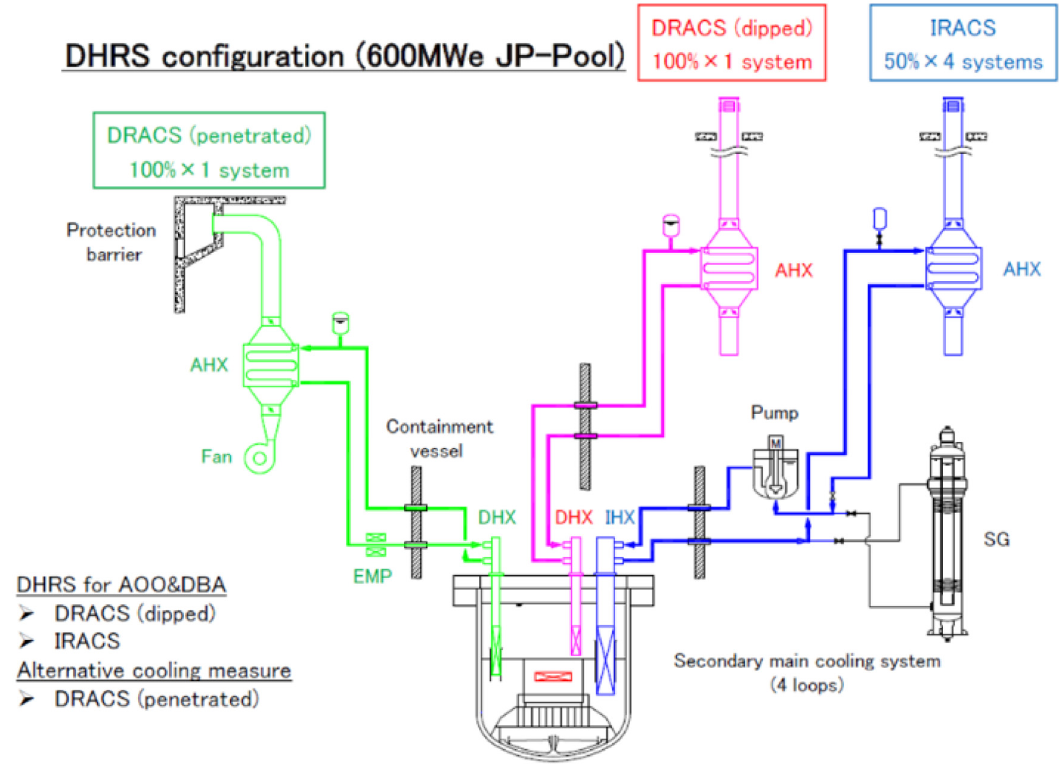
Fig. 7. Japanese proposal of DHRS (600MWe plant).